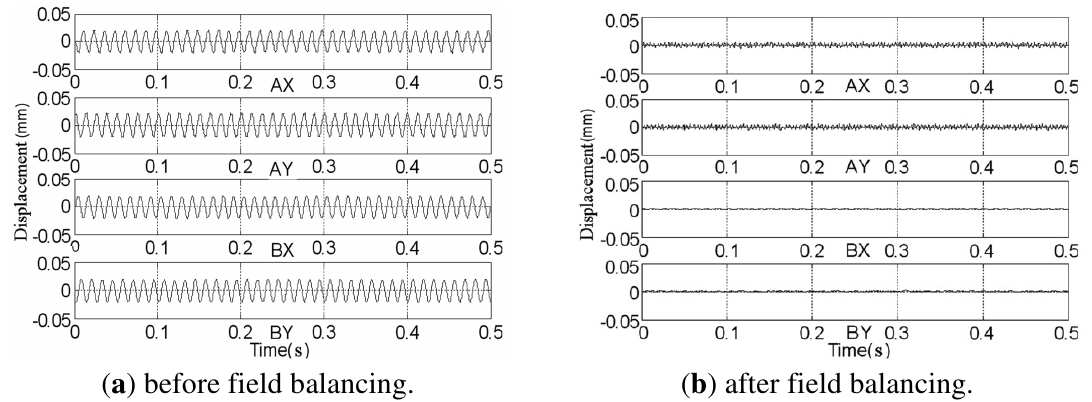
Figure 20. Rotor displacement at 80 Hz.